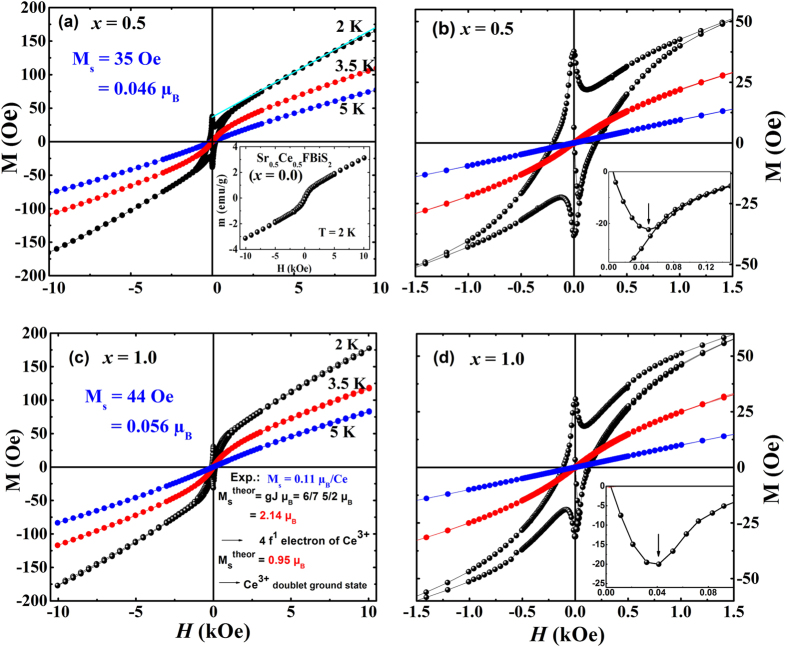
Hysteresis loops at different temperatures for Sr0.5Ce0.5FBiS1.5Se0.5 and Sr0.5Ce0.5FBiSSe in H ≤ 10 kOe (a) and (c) and H ≤ 1.5 kOe (b) and (d). The superconducting loop is superimposed on the ferromagnetic loop at 2 K. Inset in Fig. 4(a) shows the ferromagnetic hysteresis loop for x = 0 composition. Insets in Fig. 4(b) and (d) show initial diamagnetic signal with arrows indicating lower critical field, Hc1.